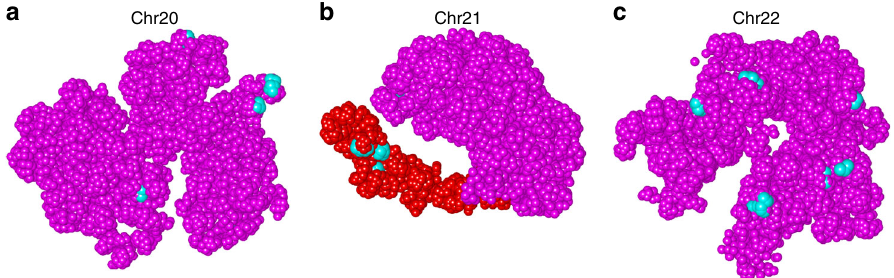
Fig. 7 Super-enhancers tend to lie on the surface of the 3D models of chromosomes. a – c Super-enhancers (cyan) lie on the surfaces of the 3D models reconstructed by GEM-FISH for Chrs 20, 21, and 22, respectively. For Chr21 ( b ), four of the fi ve super-enhancers were found in the gene-rich G-band q22.3 region, which is shown in red. The visualization was performed using UCSF Chimera